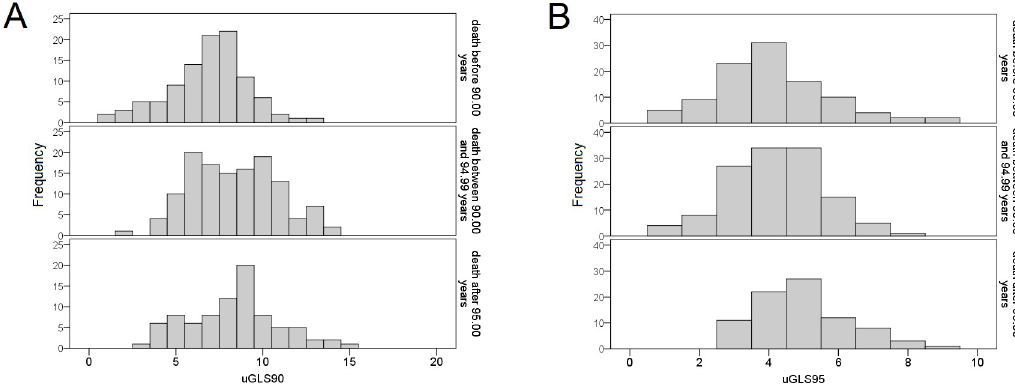
Fig 3. Distribution of two unweighted genetic longevity scores in three age-at-death groups. Histograms show the distribution of A) uGLS90, and B) uGLS95 among the participants belonging to a specific age-at-death group: < 90.00 years, 90.00–94.99 years, and 95.00+